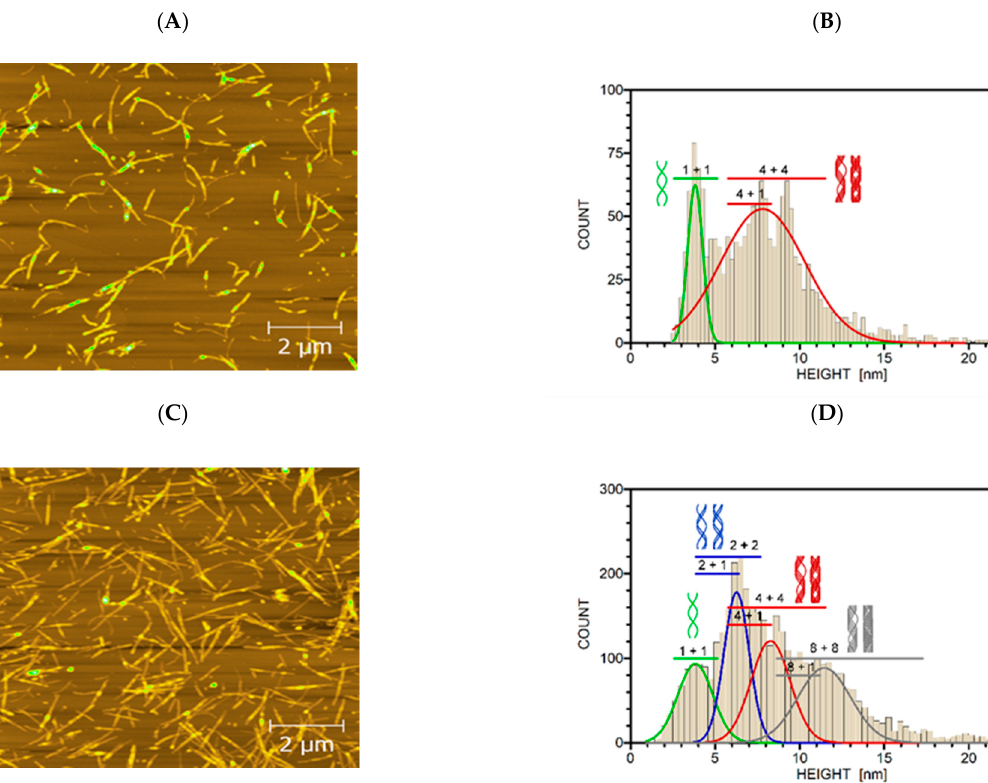
Figure 3. AFM image of lysozyme fibrils formed in 1% EMIM-ac ( A ) and EMIM-BF 4 ( C ). The corresponding histograms of height distribution of fibril ridges with the schematic model of fibril types. ( B ) About 1600 fibril cross-section profiles were used to build histograms and ( D ) about 3900 fibril cross-section profiles were used to build histograms.